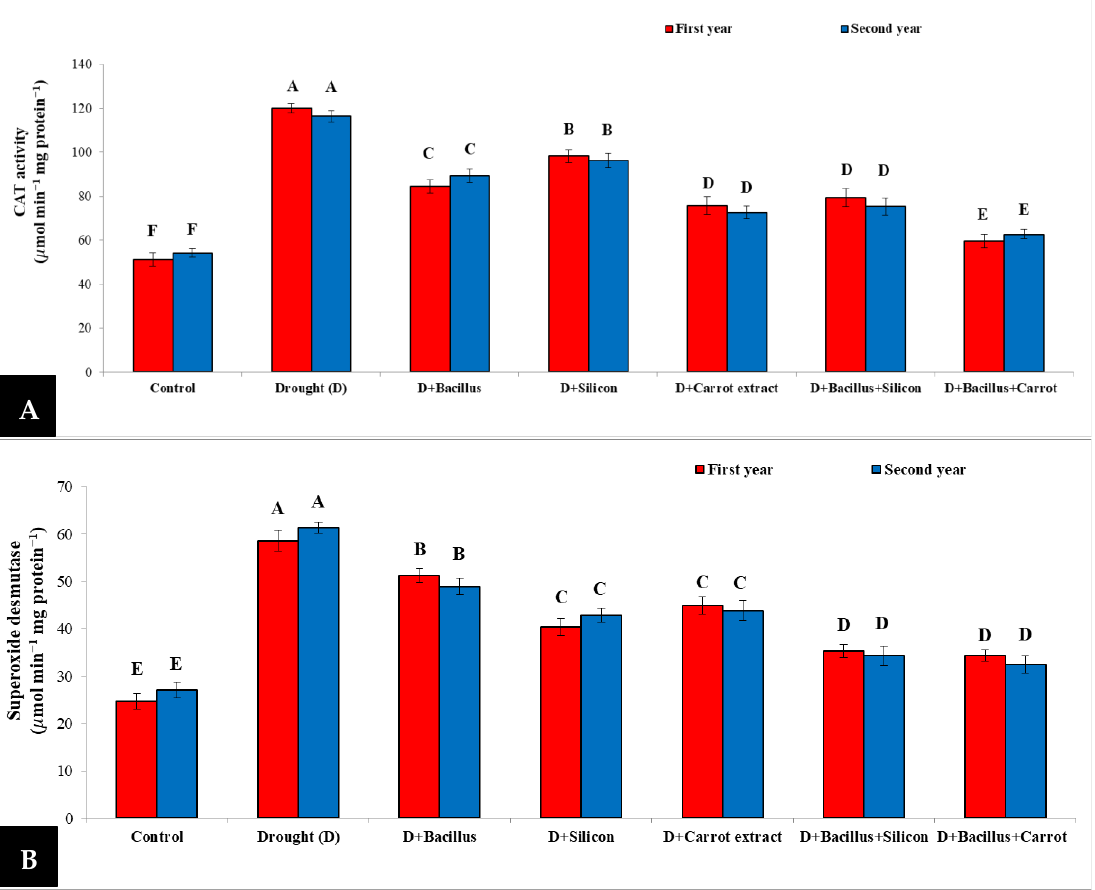
Figure 7. Effect of Bacillus thuringiensis , silicon and carrot extract on catalase activity (CAT) ( A ) and superoxide dismutase (SOD) ( B ) of drought-stressed pea plants during 2019/2020 and 2020/2021 seasons. Different letters on the columns show significant differences between the treatments according to ANOVA, and Duncan’s post hoc test when the result of the omnibus multivariate F-test in ANOVA was significant ( p ≤ 0.05). Data is the mean (± SE) of five replicates.